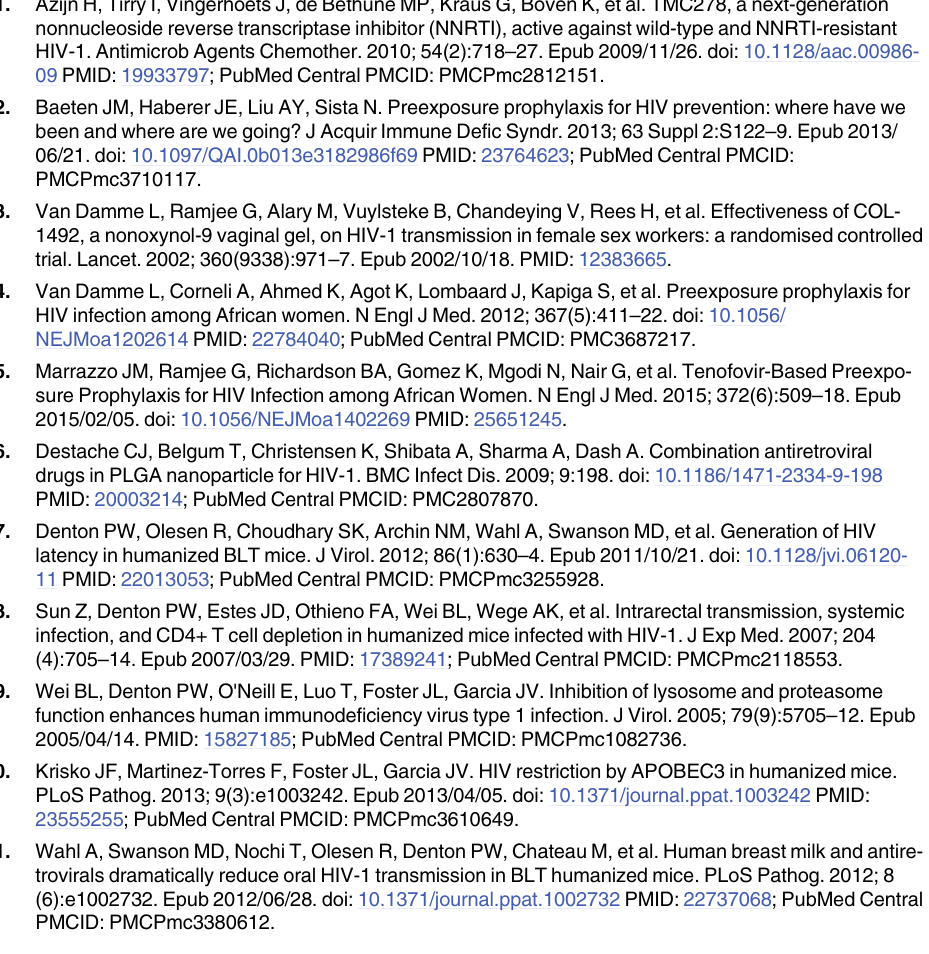
PLOS Pathogens | DOI:10.1371/journal.ppat.1005075 August 13,